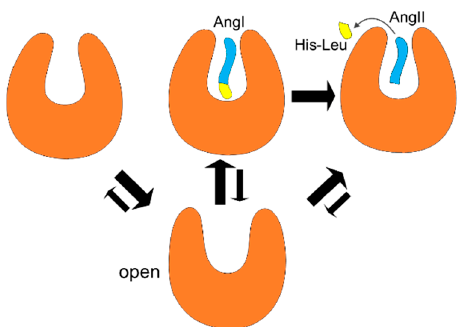
Figure 7. Activation mechanism of sACE and equilibrium shifts between the open conformation (lower panel) and closed conformations (upper panel) upon the presence of ligands: from the left to right in the figure, in the absence of a substrate (AngI), in the presence of substrate, and in the presence of product (AngII), respectively. Equilibrium shifts between two states are represented qualitatively by the size of arrows.